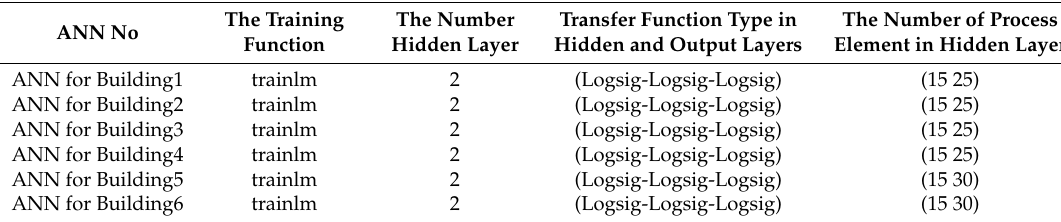
Table 6. Final topology for each ANN